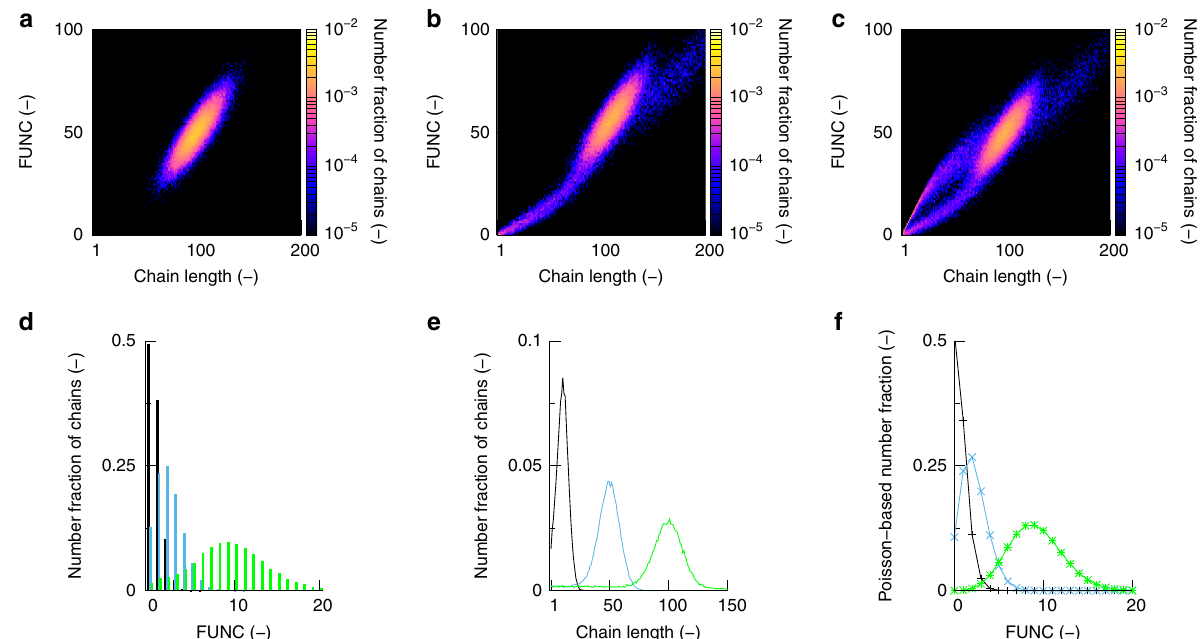
Fig. 6 Understanding the distributed nature of functionalization with 2-oxazoline. Top row: impact of side reactions on FUNC-CLD under equimolar conditions (total monomer concentration: 3 mol L − 1 ; solvent acetonitrile; target DP of 100; 140 °C; overall monomer conversion of 100%) a formally no chain transfer. b with chain transfer but formally without chain initiation of the formed oxazolinium fragment. c with chain transfer and the latter chain initiation (identical to Fig. 5g) Bottom rowmarginal distributions of FUNC-CLD depicted in Fig. 5h (10 mol % initially for C2MestOx) d functionalization distribution (FUNCD) and e chain length distribution (CLD) at an overall conversion of 10% (black), 50% (blue), and 100% (light green); additionally f Poisson distributions based on mean values of the FUNCDs ( μ FUNCD ) in d ; the latter distributions are approximate and a complete FUNCD as extractable from FUNC-CLD is the preferred